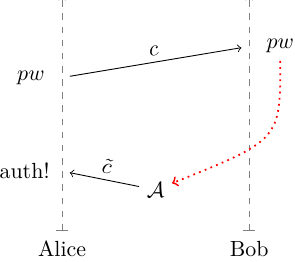
Figure 1: A confidentiality attack against the canonic composition of two IND-CCA-secure unidirectional channels. In the figure time evolves bottom-up (dashed